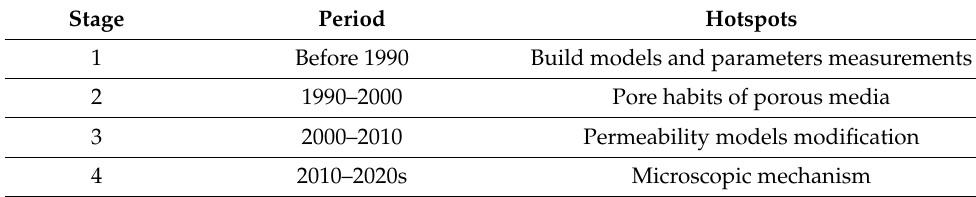
Figure 13. Advances in the research methods of NGHs in past few decades. Table 7. Main progress and hotpots of seepage theories during past few